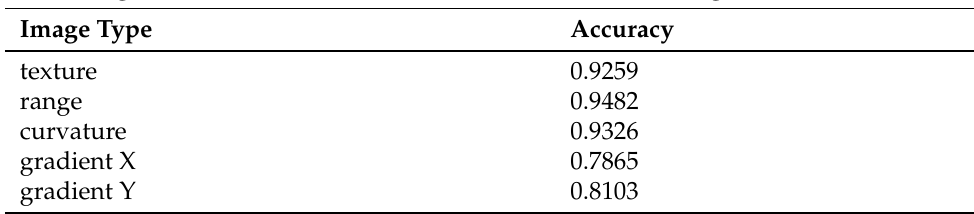
Table 3. Defect segmentation results for each photometric stereo image using our customized segmentation